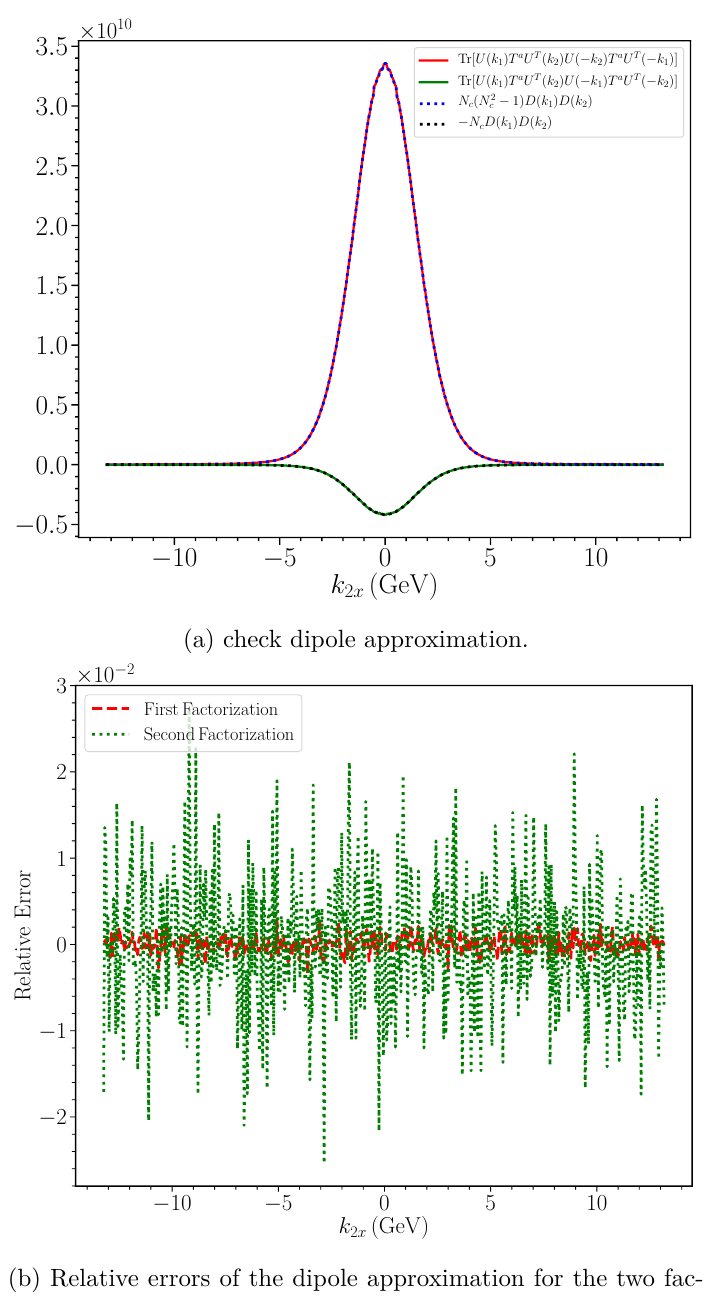
Figure 3. Two factorization relations predicted by dipole approximation are checked. The figures are plotted by choosing k 1 = (0 , − 0 . 3 GeV) and varying k 2 = ( k 2 x , 0) .